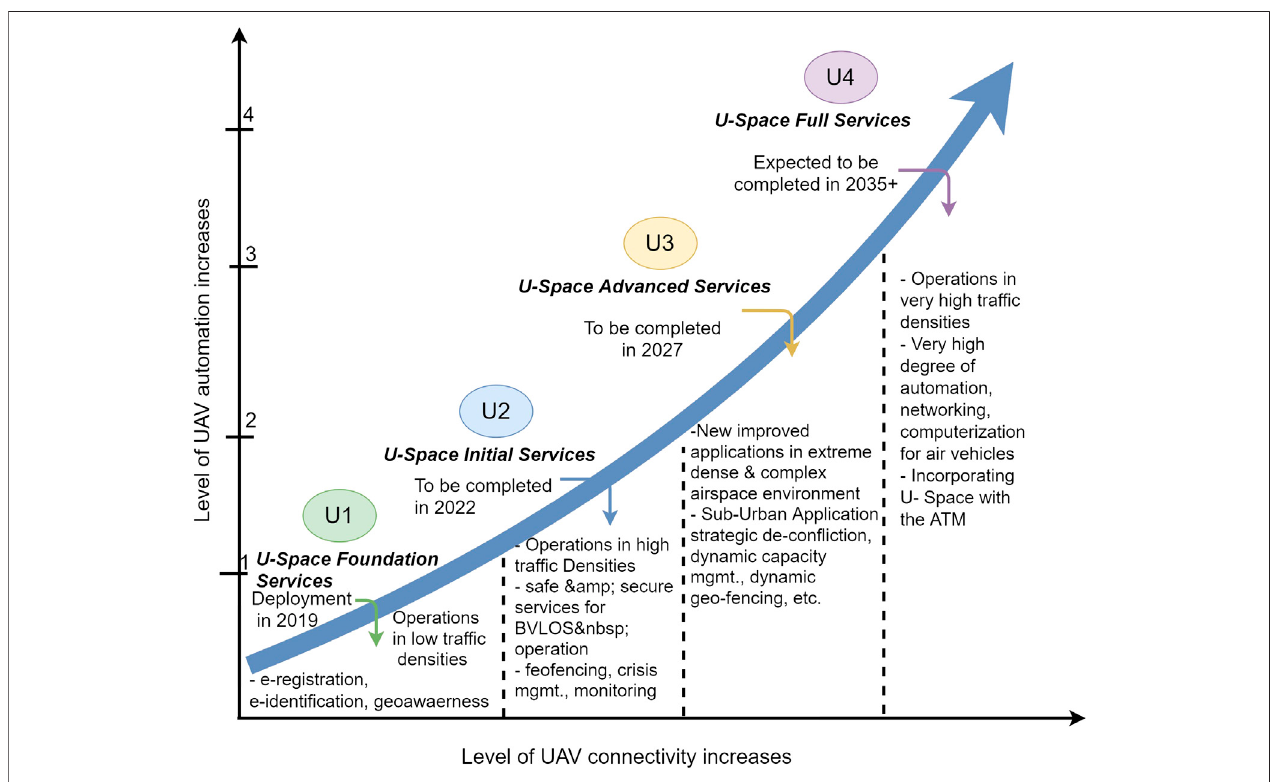
FIGURE 6 | U-space automation